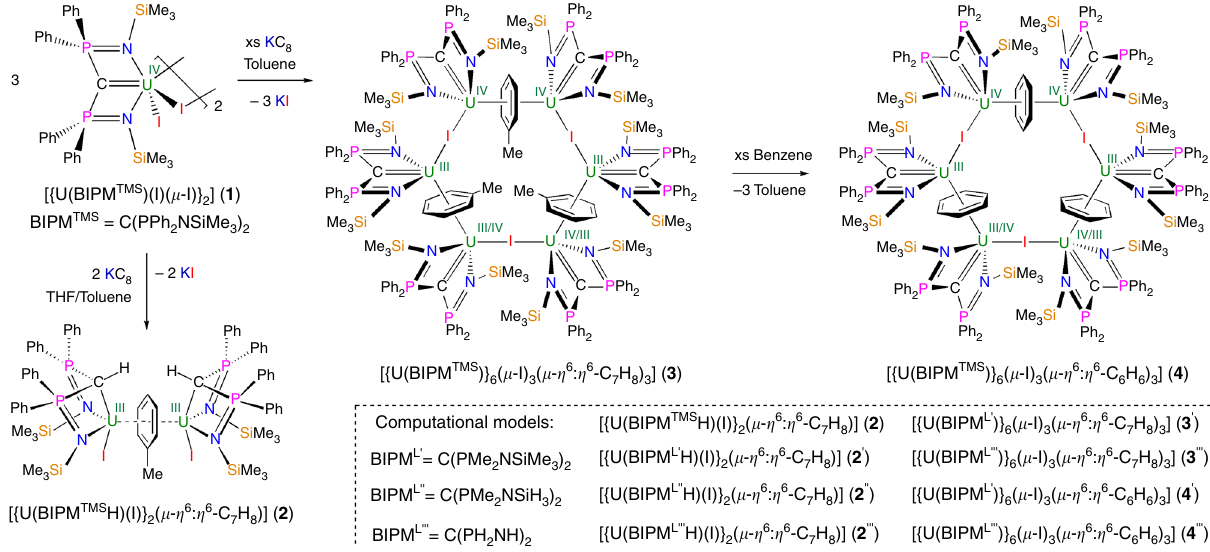
Fig. 1 Synthesis of complexes 2 , 3 , and 4 along with de fi nitions of computational models used in this study. See ref. 43 for the synthesis of complex